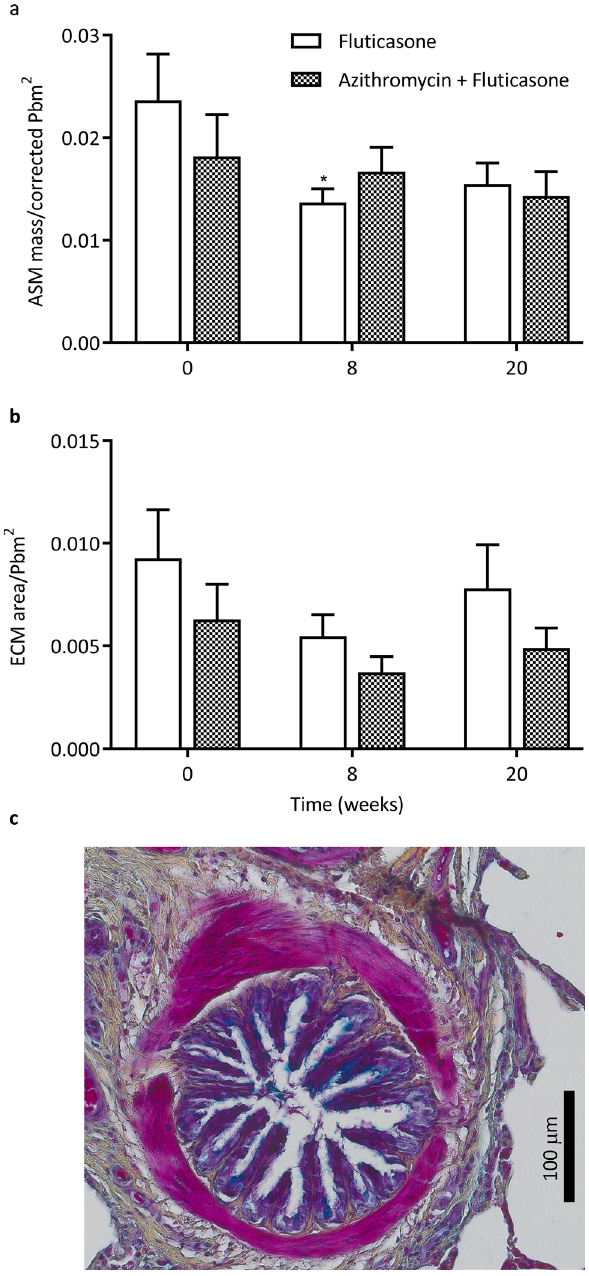
Figure 5. Peripheral bronchial remodeling. ( a ) Airway smooth muscle mass (ASM) corrected for the perimeter of basal membrane where the muscle was located (corrected Pbm 2 ) (mean and standard error of the mean). There was a significant time main effect but not group difference with the two-way ANOVA (p = 0.05). ( b ) Extracellular matrix area (ECM) corrected for the length of the basal membrane (Pbm 2 ). *p < 0.05 compared to baseline values with Dunnett’s multiple comparison tests. c) Peripheral bronchi stained with Russell-Movat-